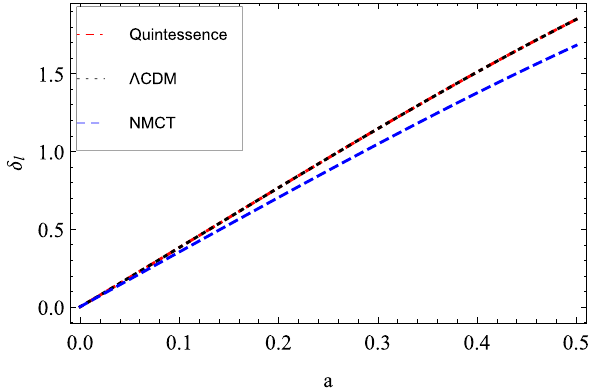
Fig. 4 The the linear evolution of overdensity parameter δ l vs the scale factor for the Λ CDM , quintessence and NMCT models